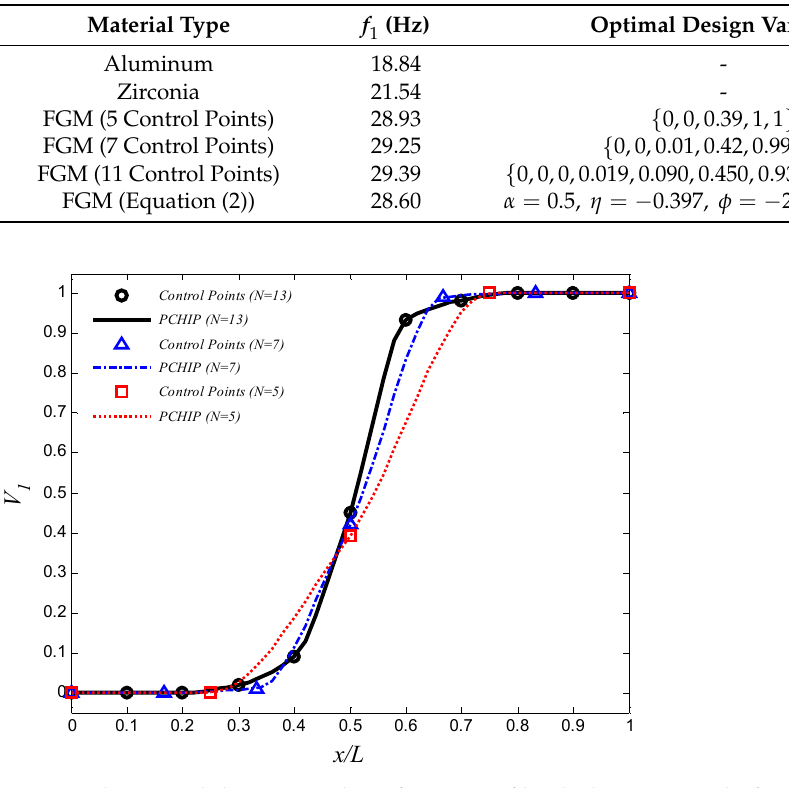
Figure 4. The optimal aluminum volume fraction profile which maximizes the fundamental frequency (control points approach).